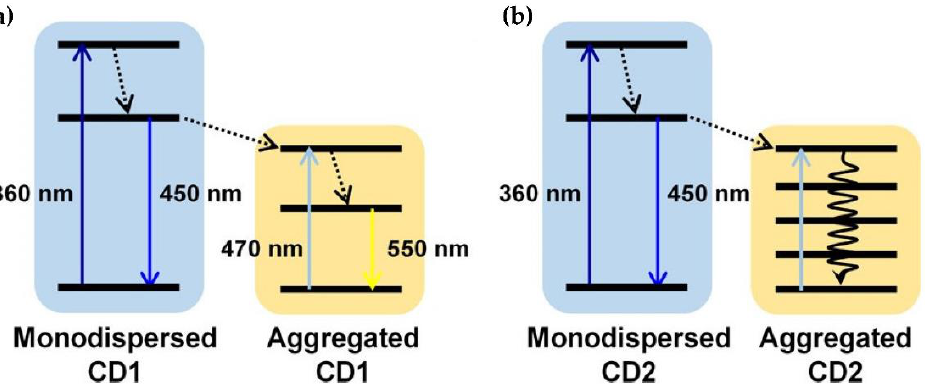
Figure 7. Energy band level alignments of monodispersed and aggregated CDs. Schematic of energy transfer that occurs in the aggregation process of ( a ) CD1 and ( b ) CD2. (Reprinted from [101]; with the permission of the American Chemical Society).